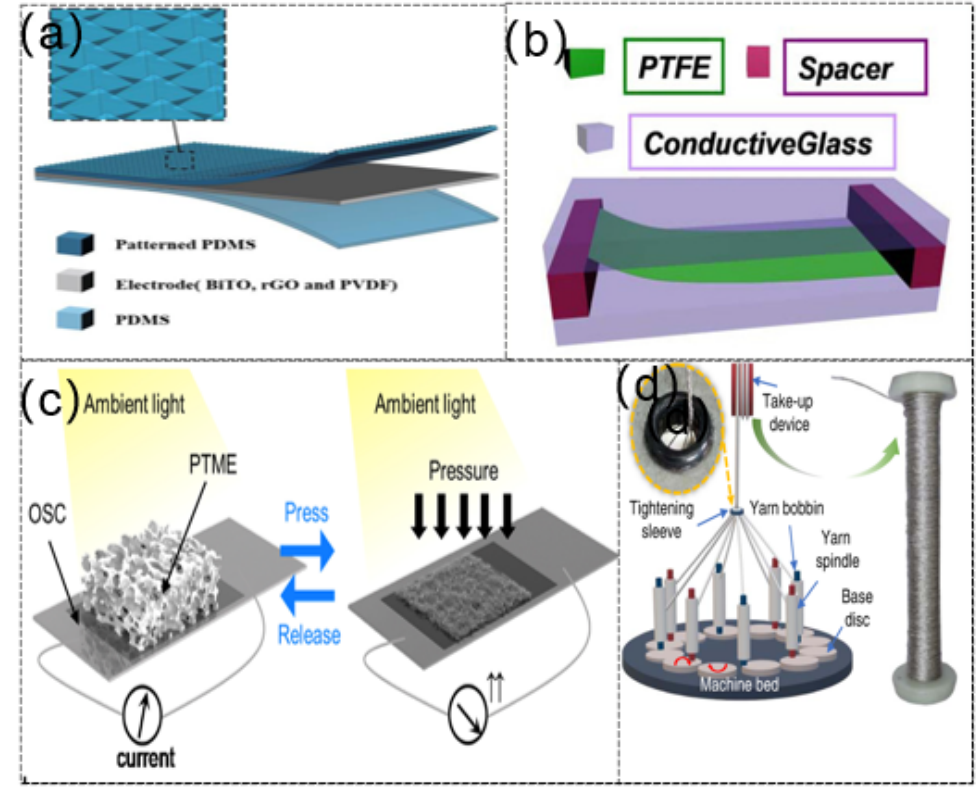
Figure 4. ( a ) Schematic illustration showing the basic structure of tactile e-skin. Reprinted with permission from Ref. [85]. Copyright 2020 Elsevier. ( b ) Schematic diagram of ATNG sensor. Reprinted with permission from Ref. [86]. Copyright